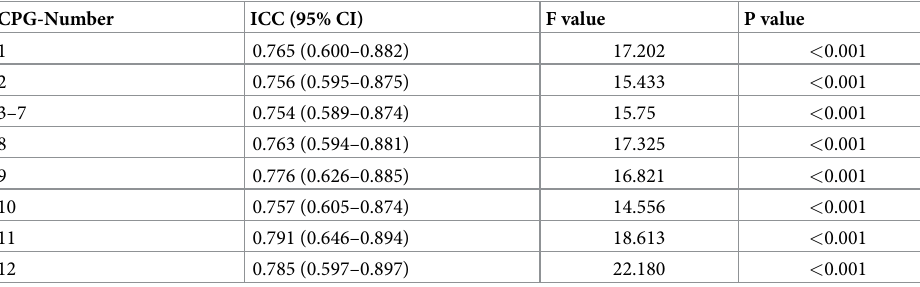
Table 3. Inter-class reliability of each